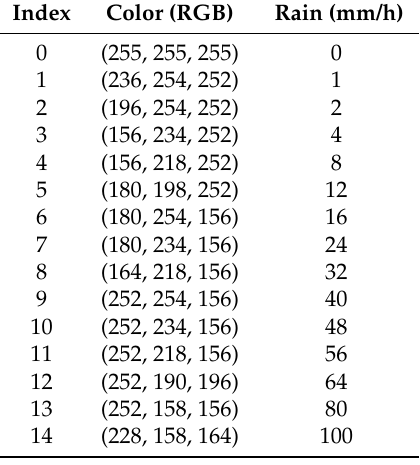
Figure 3. Climate data of monthly average temperature ( a ) and precipitation ( b ) for three meteorological stations in the domain. Table 2. Table of correspondence between the colors of the radar image representation and the precipitation